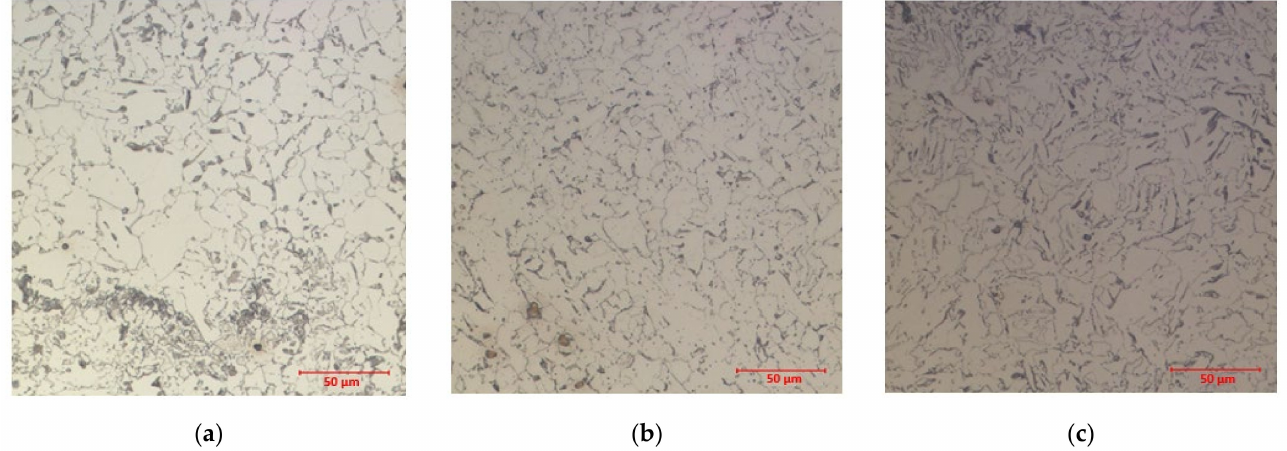
Figure 14. Microstructure of the heat-treated specimen at 800 ◦ C. ( a ) Parent material; ( b ) HAZ; and ( c ) weld metal.